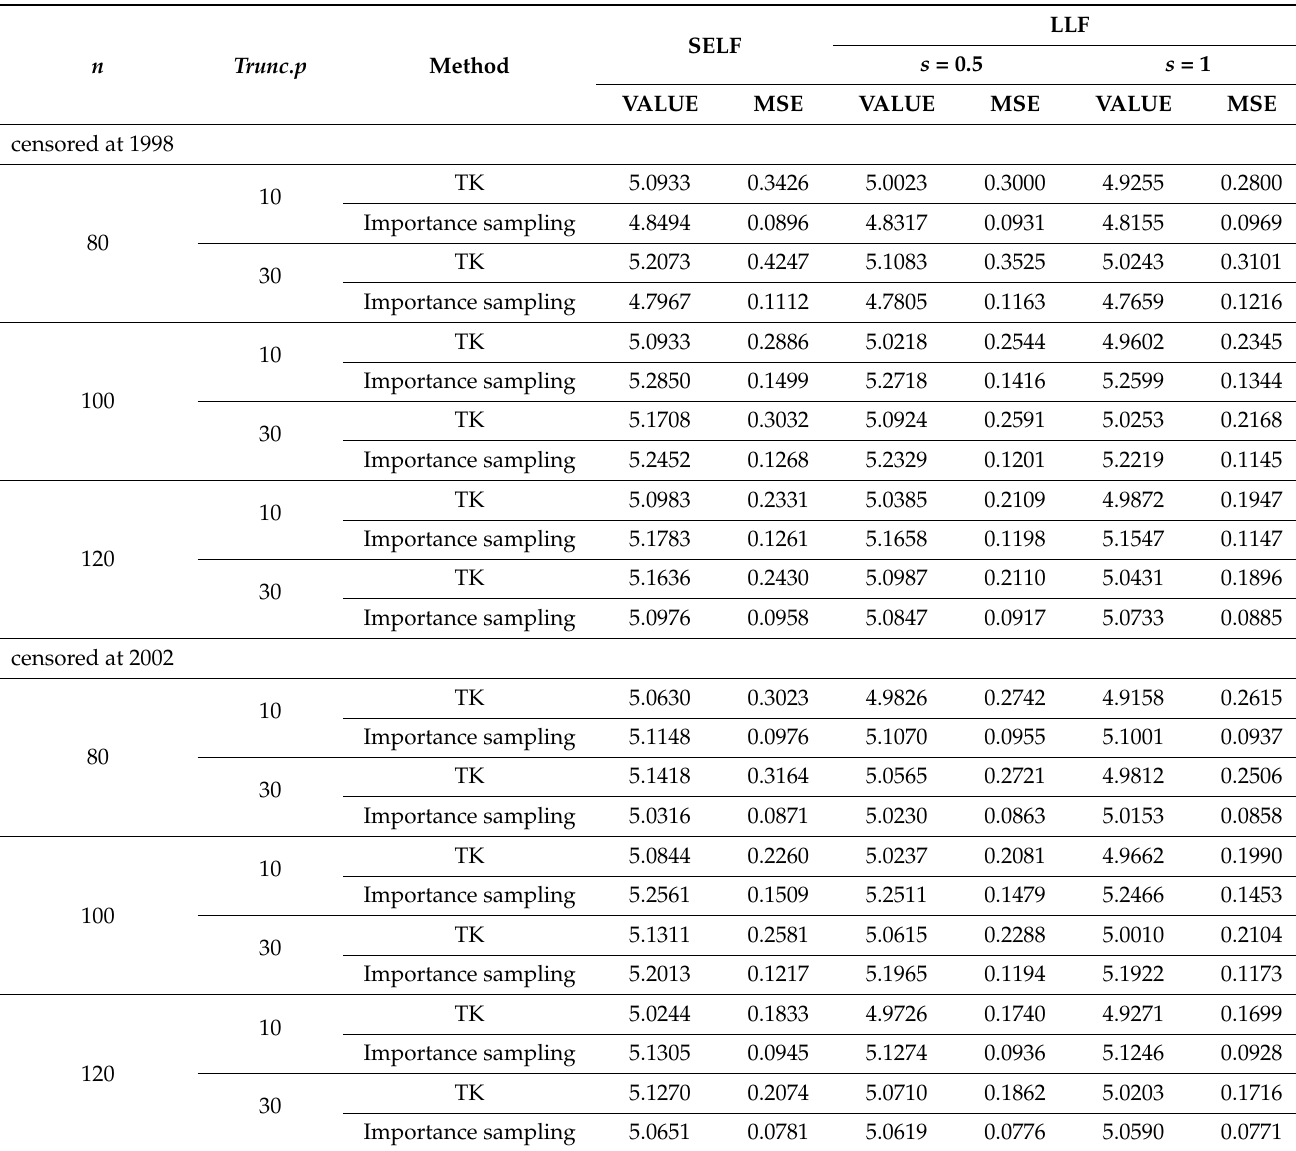
Table A3. The results of informative Bayesian estimates for σ using TK approximation and impor- tance